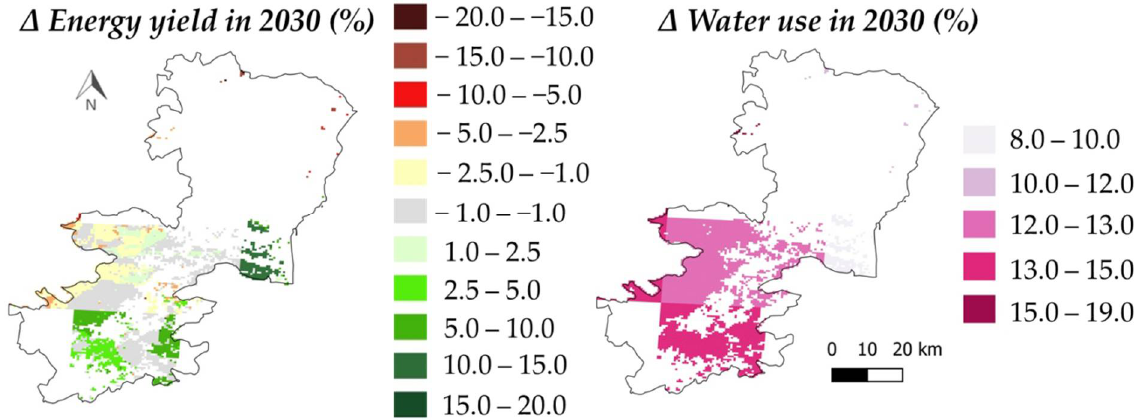
Figure 7. Projected impact of climate change on energy yield and natural water consumption in 2030 in the province of Catania. The results are shown, for each simulation unit, as percentage difference compared to the baseline.